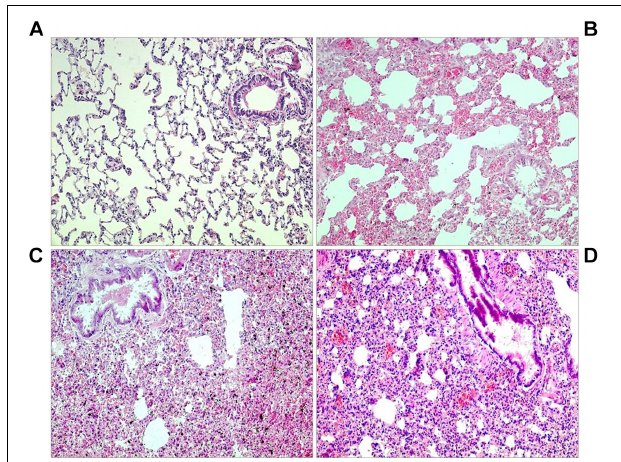
with PZ + PR infusion over 24 h ( Figure 5 ). Thirty-five rats in this subgroup additionally suffered attacks of cardiorespiratory